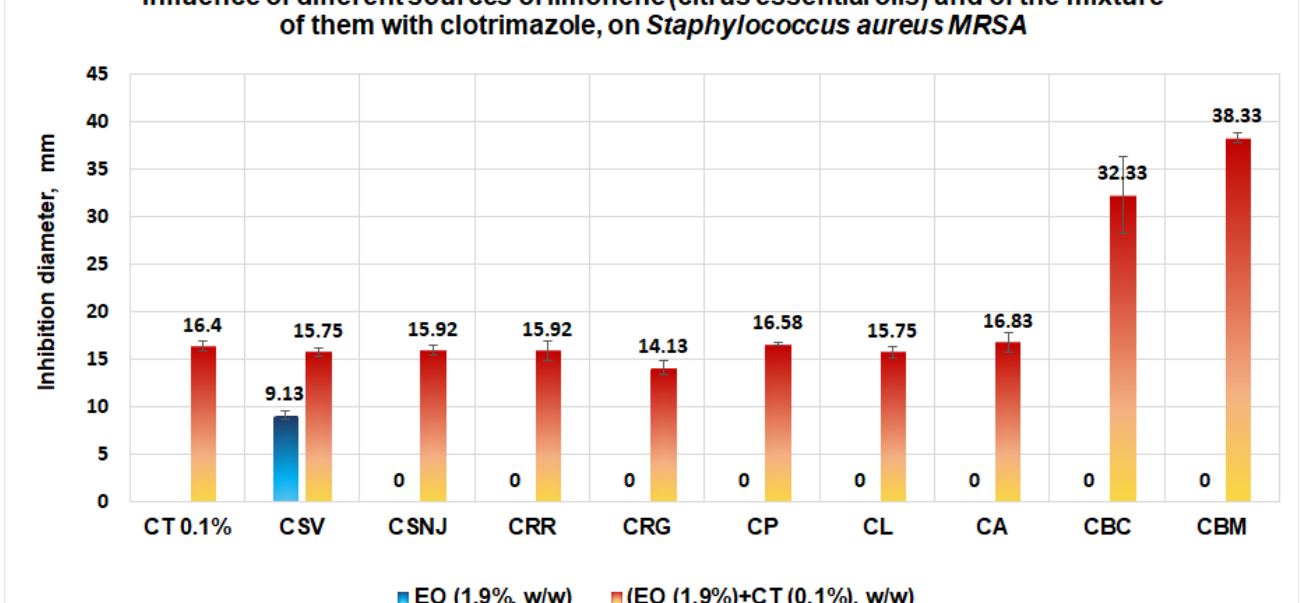
Figure 14. Influence of different sources of limonene (citrus essential oil, 1.9%, w/w) and of the mixture of them with clotrimazole (0.1%, w/w), on S. aureus MRSA. The synergistic effect is evident in the case of the mixtures between clotrimazole and the essential oils of bergamot (two sources of this essential oil).